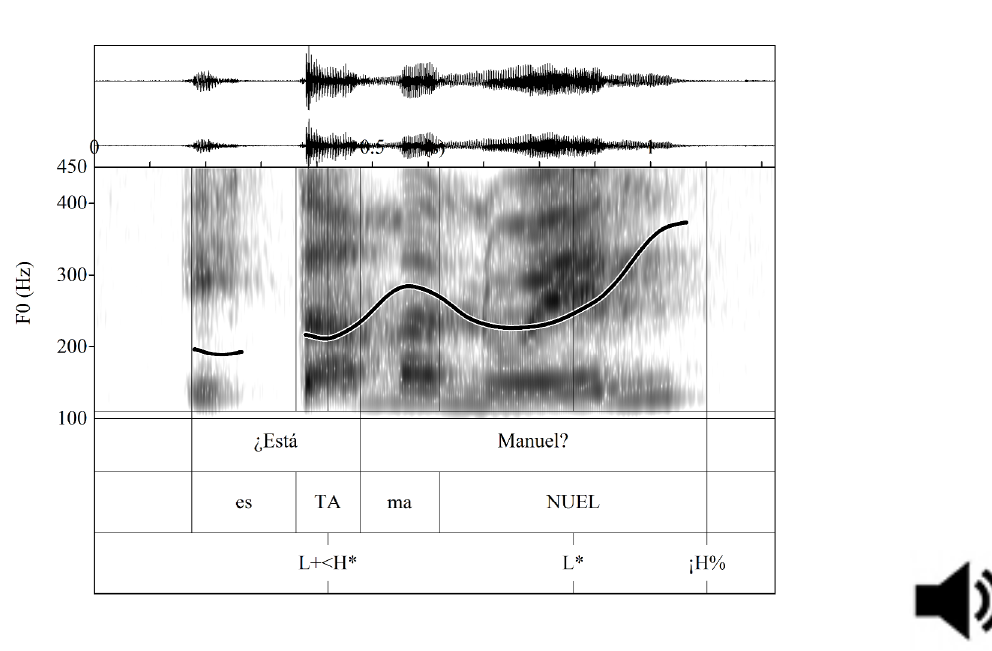
Figure 8 (Participant 13): Waveform and F0 trace for the info seeking yes-no question ¿ Está Manuel? ‘Is Manuel there?’ produ- ced with L+<H* in pre-nuclear position and L * in nuclear position followed by an ¡H% boundary